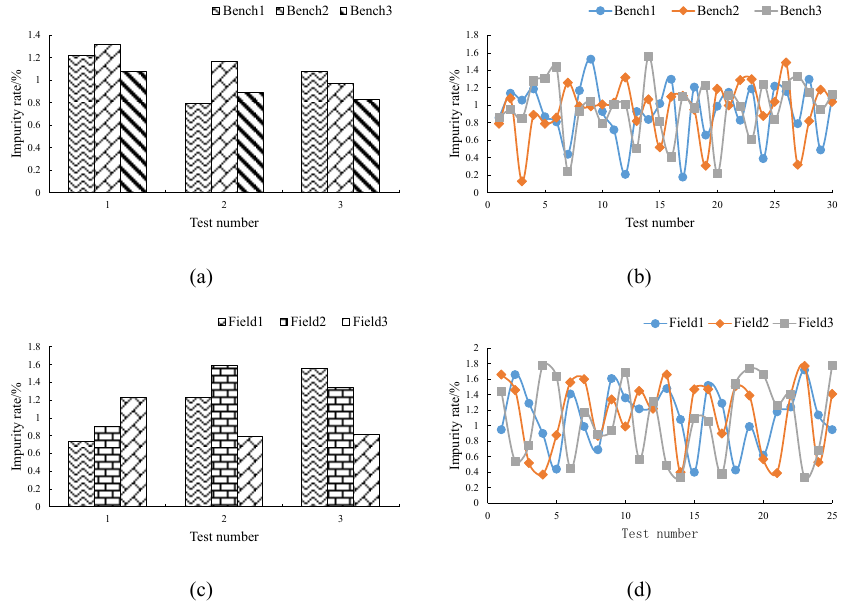
Figure 8. Detection results for the wheat impurity rate. ( a ) Manual test results from the bench test; ( b ) device test results from the bench test; ( c ) manual test results from the field test; ( d ) device test results from the field test. Table 3. Statistical data of the detection results of wheat impurity